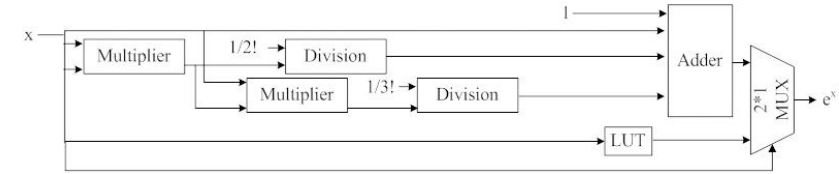
Figure 8. Block diagram of exponential function with Taylor expansion and LUT.